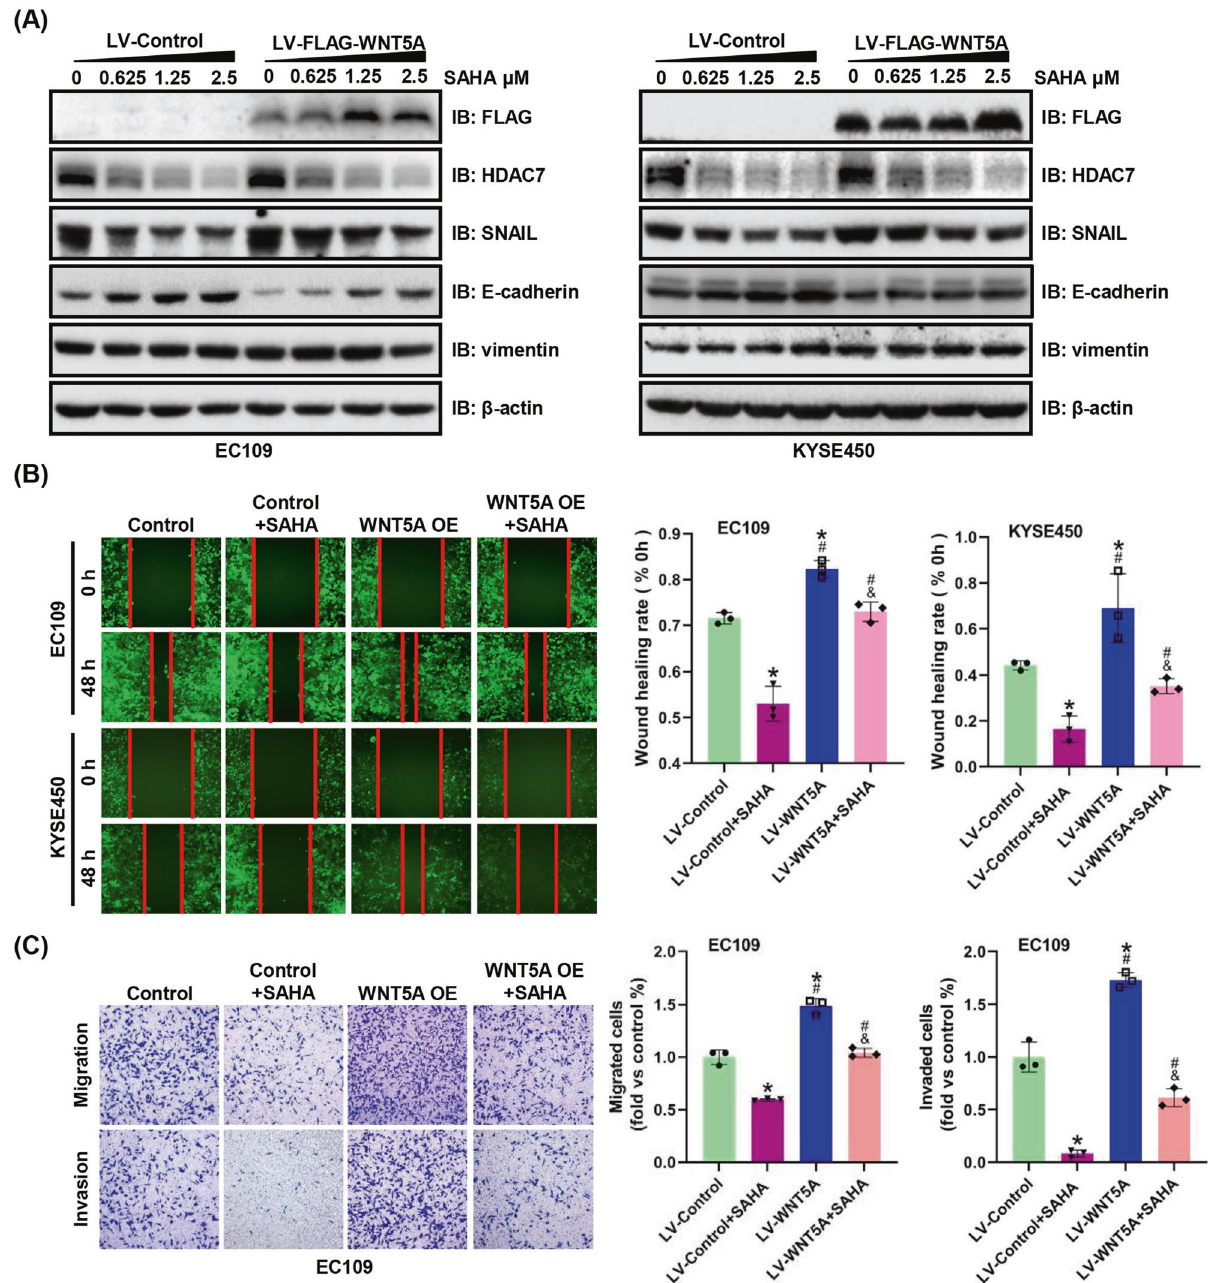
Fig. 6 SAHA inhibits WNT5A-mediated ESCC cell migration and invasion. A Representative western blots showing the levels of FLAG- WNT5A, HDAC7, SNAIL, E-cadherin, and vimentin in WNT5A-overexpressing EC109 and KYSE450 cells after treatment with SAHA for 48 h. β -actin was used as an internal control. B , C Representative images and statistical analysis of wound healing assays and Transwell migration/ invasion assays using WNT5A-overexpressing ESCC cells after treatment with SAHA (1.25 μ M) for 48 h. The migratory ability in wound healing assays was expressed as the mean scratch area. The initial scratch area (0 h) was set to 100%. * P < 0.05 compared with the LV-Control group, # P < 0.05 compared with the LV-Control + SAHA group, and & P < 0.05 compared with the LV-WNT5A group. LV in our experiments. The WNT5A-overexpressing and control EC109/KYSE450 cell lines were treated with SAHA or TMP269 at various concentrations for 48 h. Notably, in both cell lines, the changes of HDAC7, SNAIL, and E-cadherin expression induced by WNT5A overexpression were inhibited by SAHA or TMP269 in a dose-dependent manner, whereas the level of the vimentin protein did not change (Figs. 6A, 7A). Furthermore, the migratory and invasive capacities were signi fi cantly restrained, and the